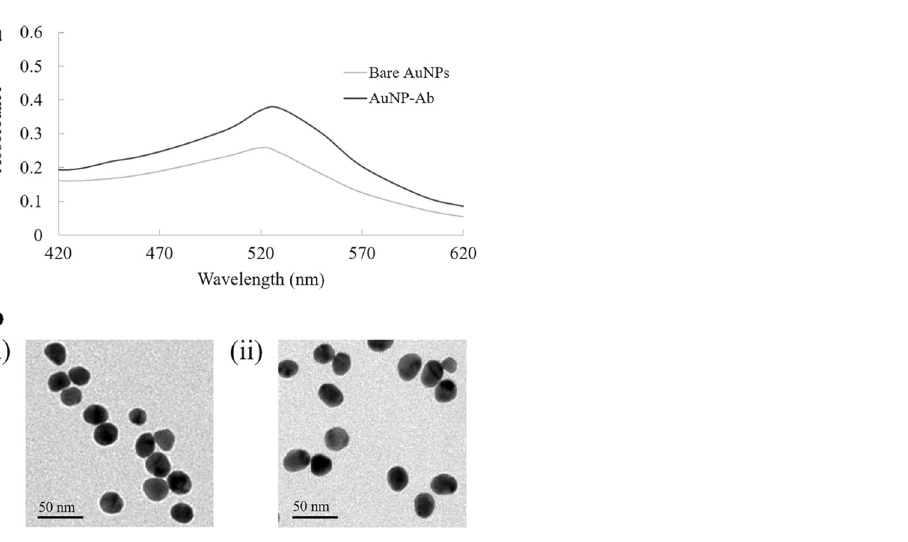
Figure 2. ( a ) Surface plasmon extinction spectra (by UV–visible spectra) of bare and Ab-conjugated AuNPs. ( b ) Transmission electron microscopic images of (i) AuNPs and (ii) Ab-conjugated